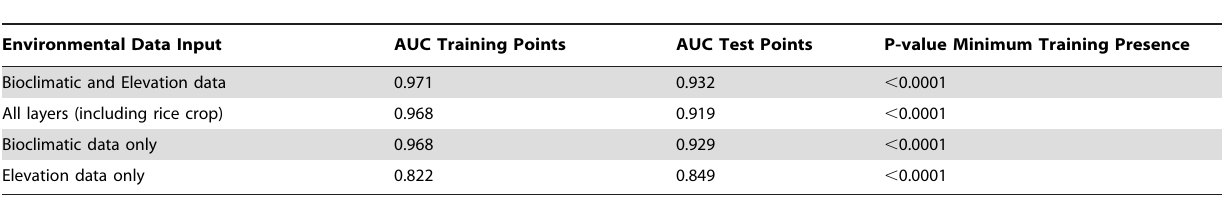
Table 3. Maxent model accuracy analysis using different sets of environmental data